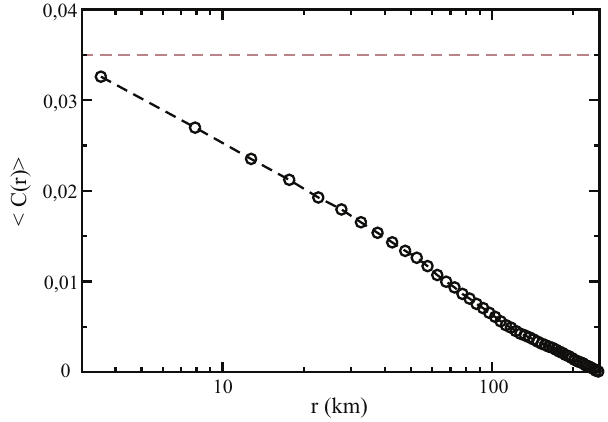
Figure 7. Average of spatial correlations C ( r ) for all French elections (absent the 2 Municipales elections). In dashed lines: & 0 : 035 , as extracted from the asymptotic ( N ? ? ) dependence of s 2 b 2 s 2 w